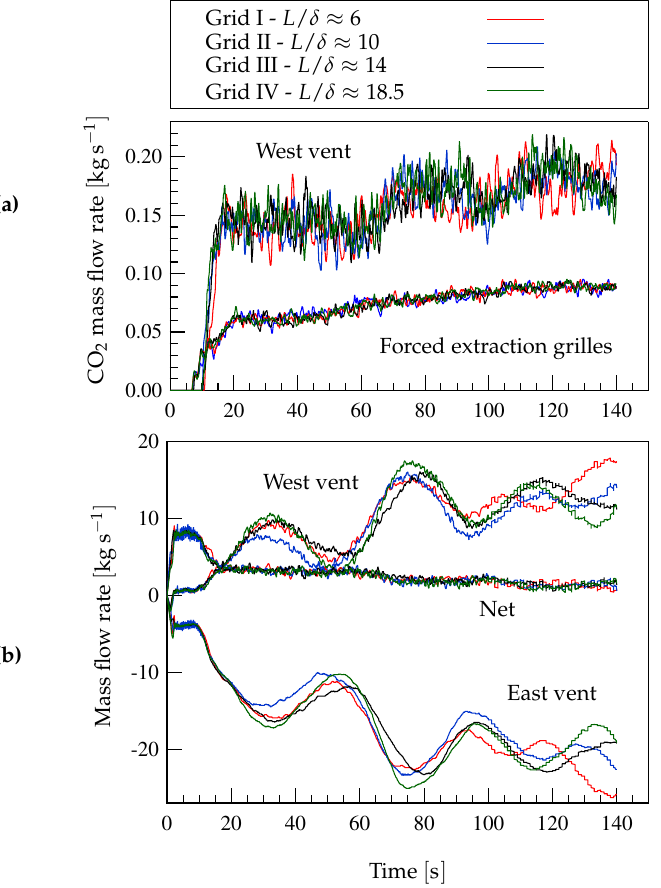
Figure 2. (a) Mass flow rates of CO 2 through the ventilation systems and (b) mass flow rates through the west and east vents (positive outwards) and net mass flow rate leaving the compartment, obtained with FDS, the simplified fire model with T in = 1500 K (Case G-4 in Table 1) and grids with L / δ 6, 10, 14 and 18.5.